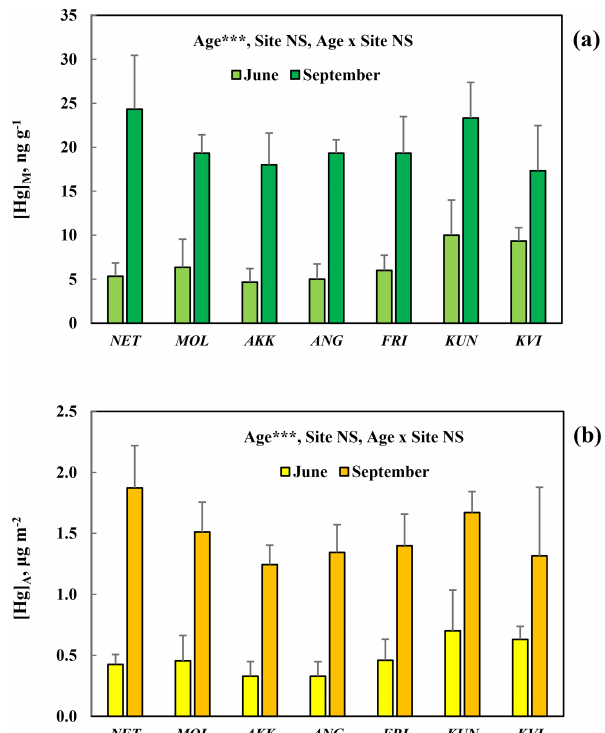
Figure 5. Mass-based [Hg] M (a) and area-based [Hg] A (b) con- centrations of mercury in leaves sampled in June and September of seven broadleaved tree species ( Betula pendula , Fagus orientalis , Juglans ailanthifolia , Populus tremula , Prunus sargentii , Quercus robur , Sorbus commixta ) and one deciduous conifer ( Larix de- cidua ) in the Gothenburg Botanical Garden Arboretum. Error bars show the standard deviation for the three trees sampled per species; ∗∗∗ p < 0 . 001; ∗∗ p < 0 . 01; ∗ p < 0 . 05; NS, non-significant.